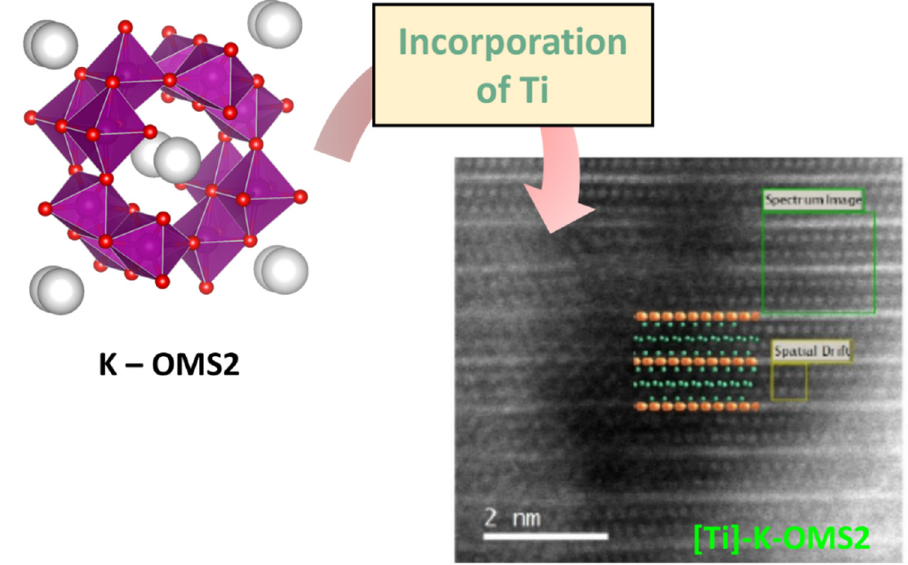
Figure 8. Scheme of Ti species into K–OMS–2. HAADF images (extracted from [144]) along the [111] zone axis, indicating the area where the spectrum image was acquired. A schematic representation of the structure is also included. The area of the image used to automatically avoid spatial drift of the sample during Dual EELS acquisition is also marked [144].